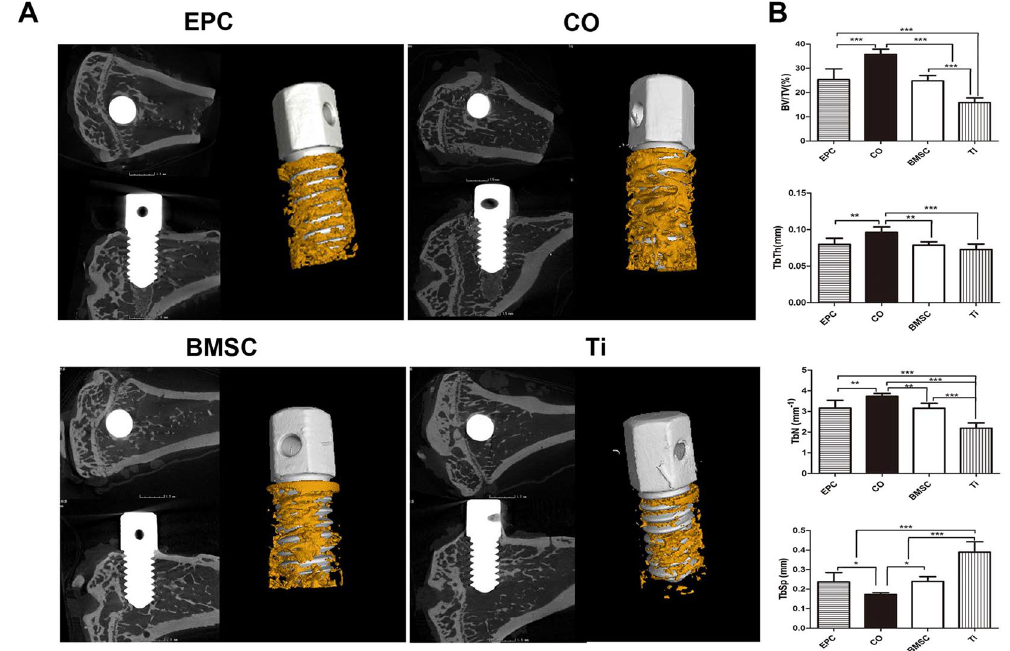
Figure 5. Micro-CT evaluation of bone osseointegration at 8 weeks after implantation. ( A ) 2D and 3D reconstructed images of the morphology of bone formed around implants. ( B ) Morphometric analysis of the BV/TV, Tb.N, Tb.Th and Tb.Sp. ( * p < 0.05, ** p < 0.01, *** p < 0.001).